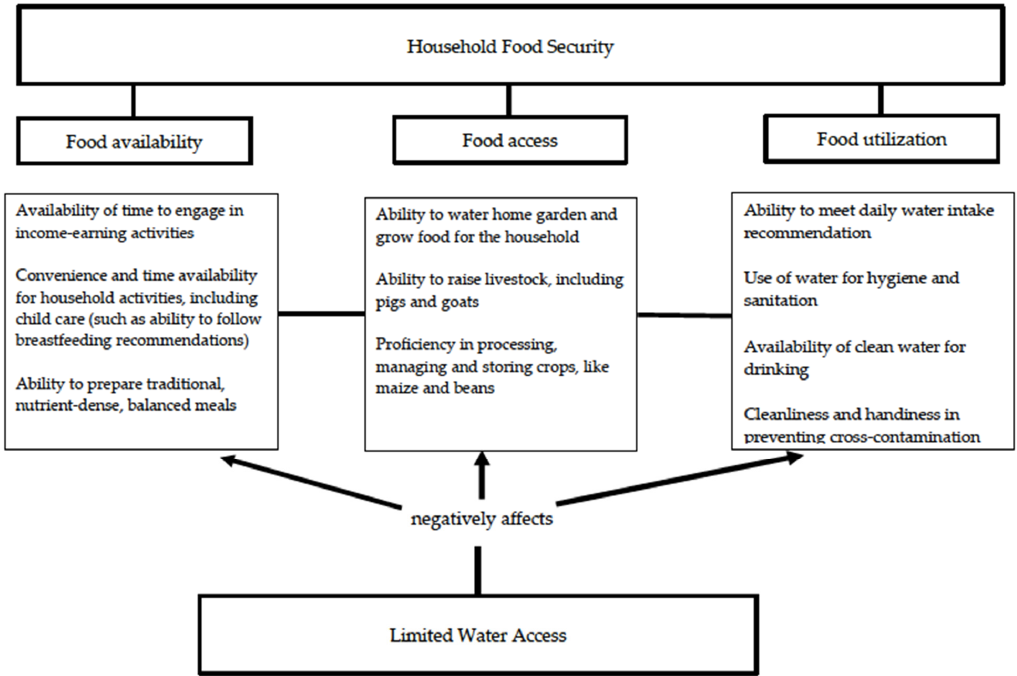
Figure 1. Diagram of potential pathways through which limited water access increases the risk of food insecurity among families living in the West Region in